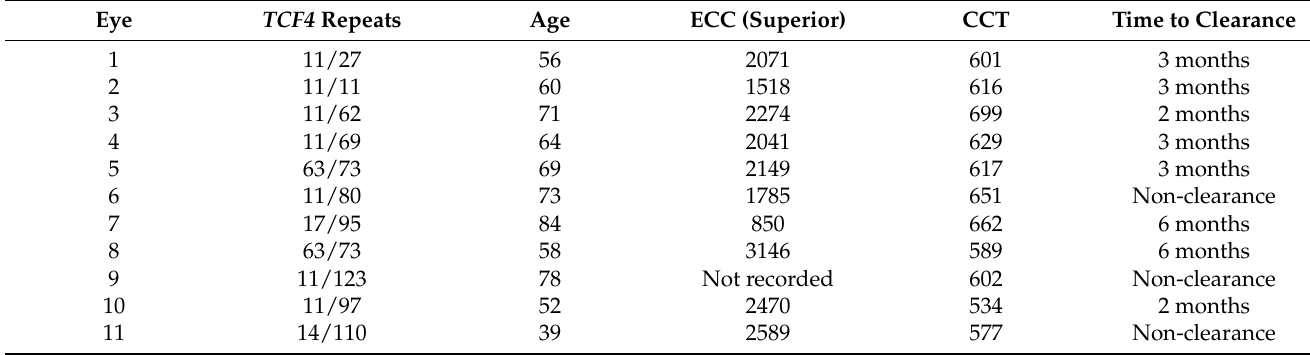
Table 1. Demographic details and pre-operative phenotypes, as well as time to clearance of the 11 eyes included in the study.